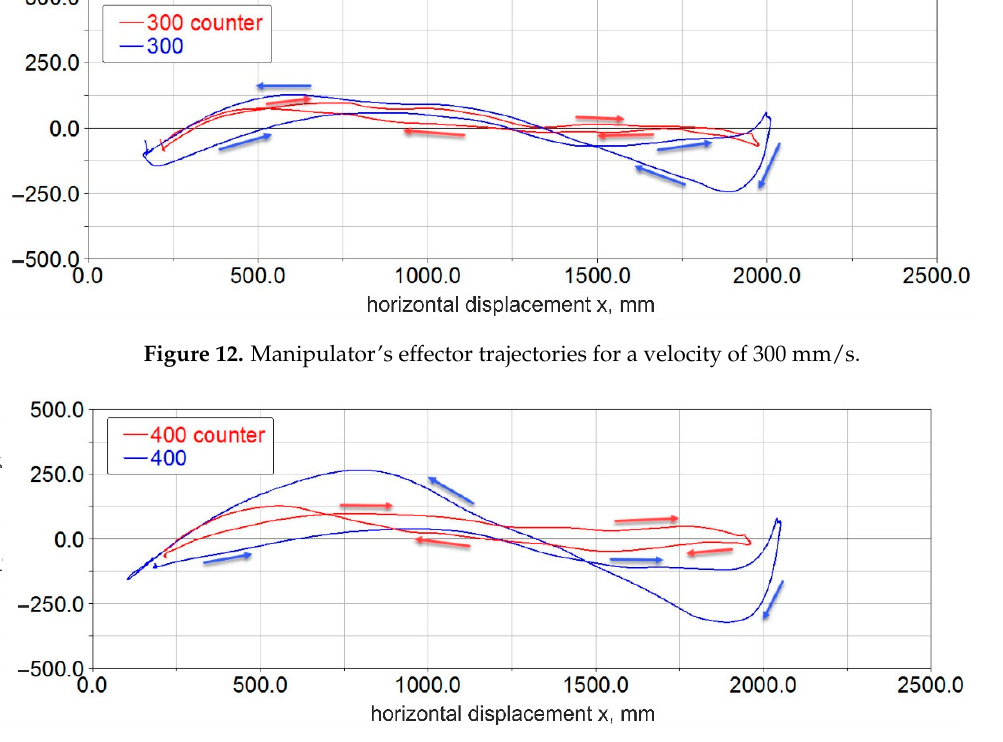
Figure 13. Manipulator’s effector trajectories for a velocity of 400 mm/s.